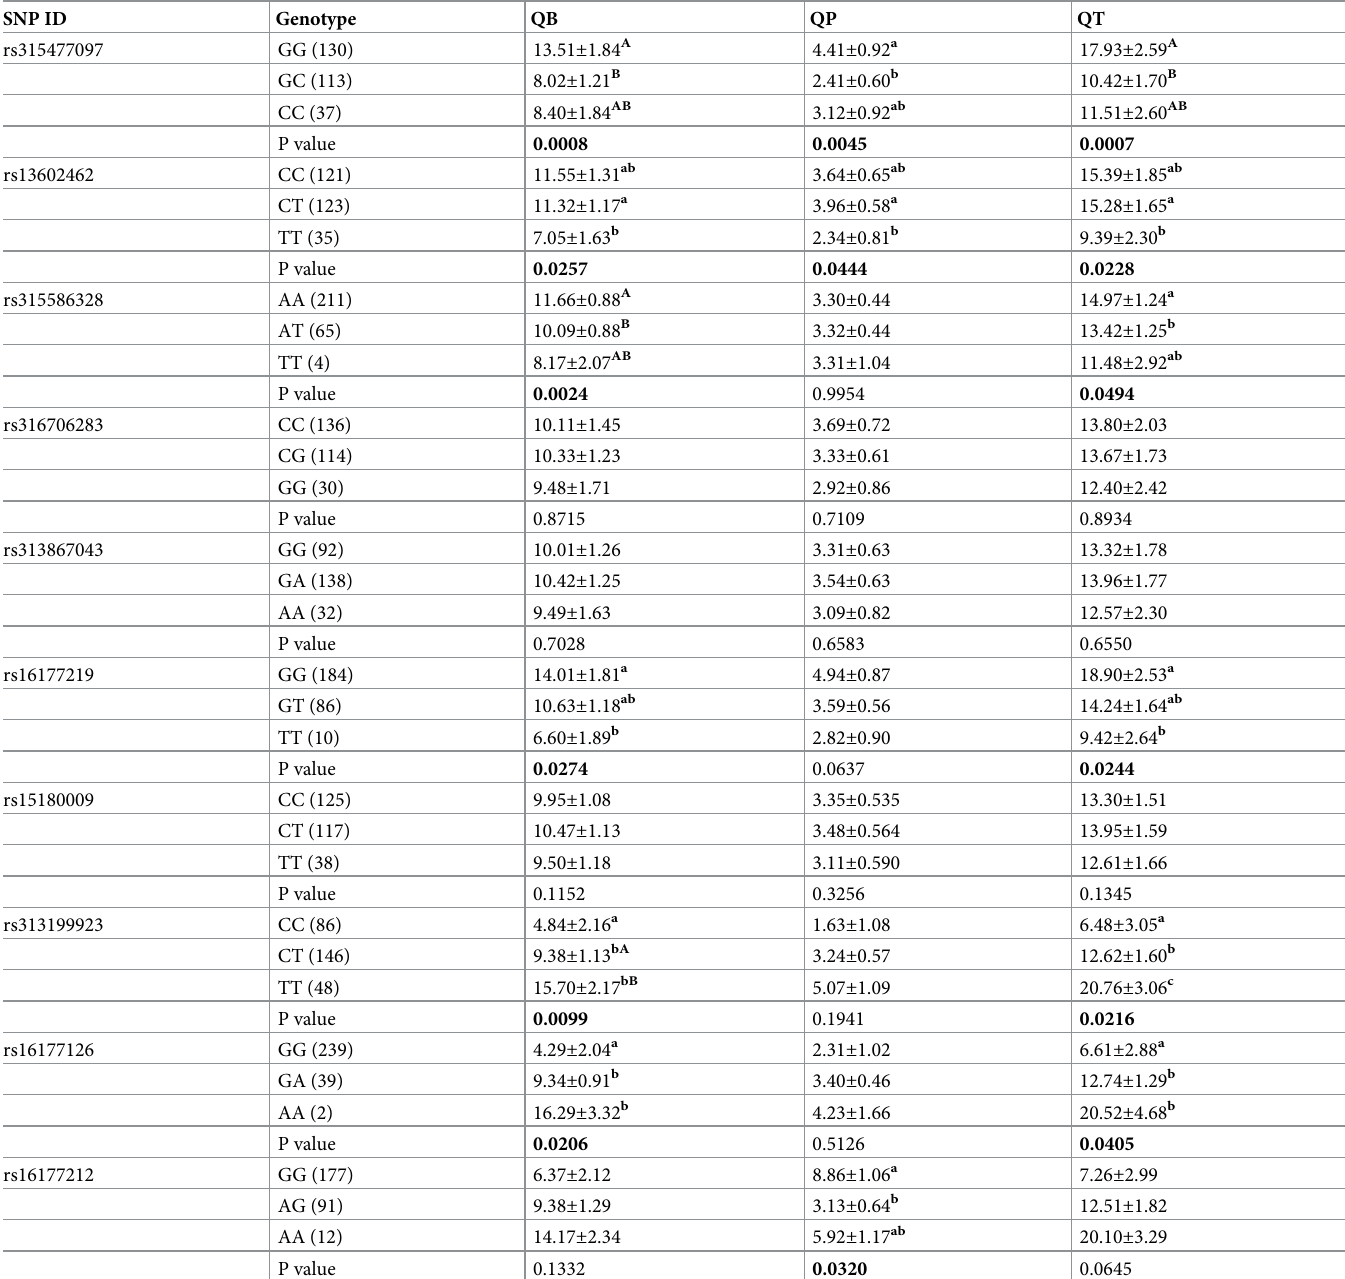
Table 7. Effect of 10 SNPs on eggshell color intensity trait in N280